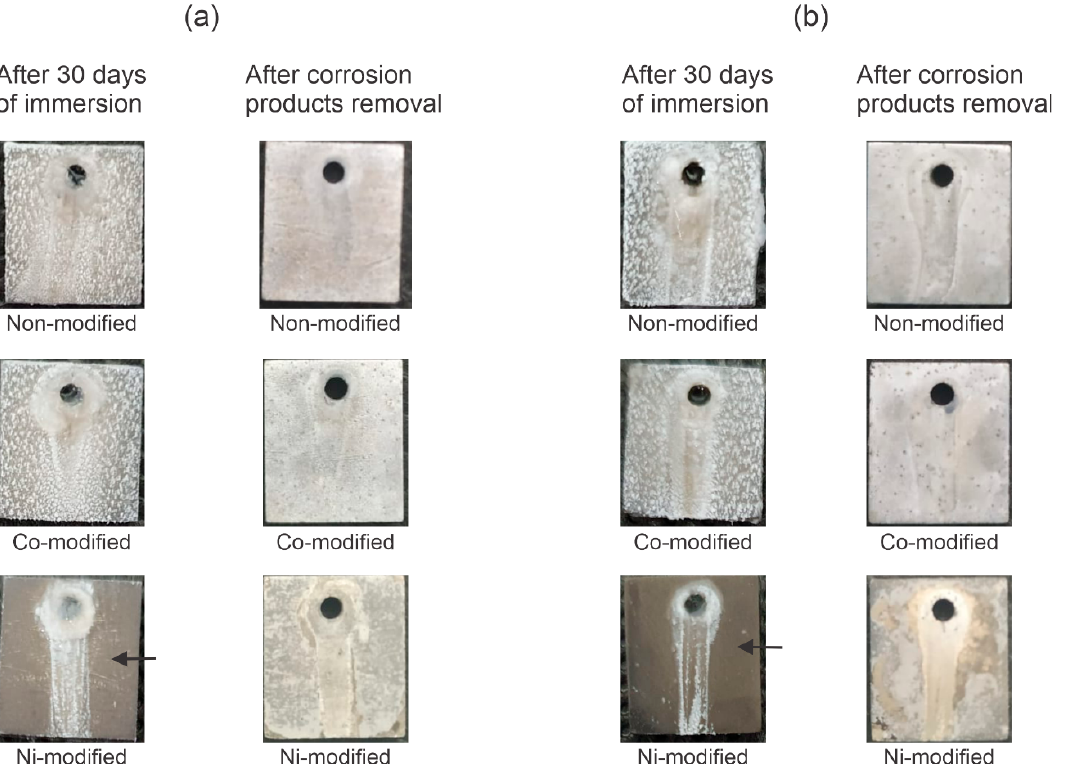
Figure 9. Macroscopic images of ( a ) DS and ( b ) CC Al-7%Si-0.6%Fe-0.35%Cu-0.25%Zn, Al-7%Si-0.6%Fe-0.35%Cu-0.25%Zn-0.5%Co and Al-7%Si-0.6%Fe-0.35%Cu-0.25%Zn-0.5%Ni alloys after 30 days of immersion tests. Arrows indicate a more uniform grayish layer.